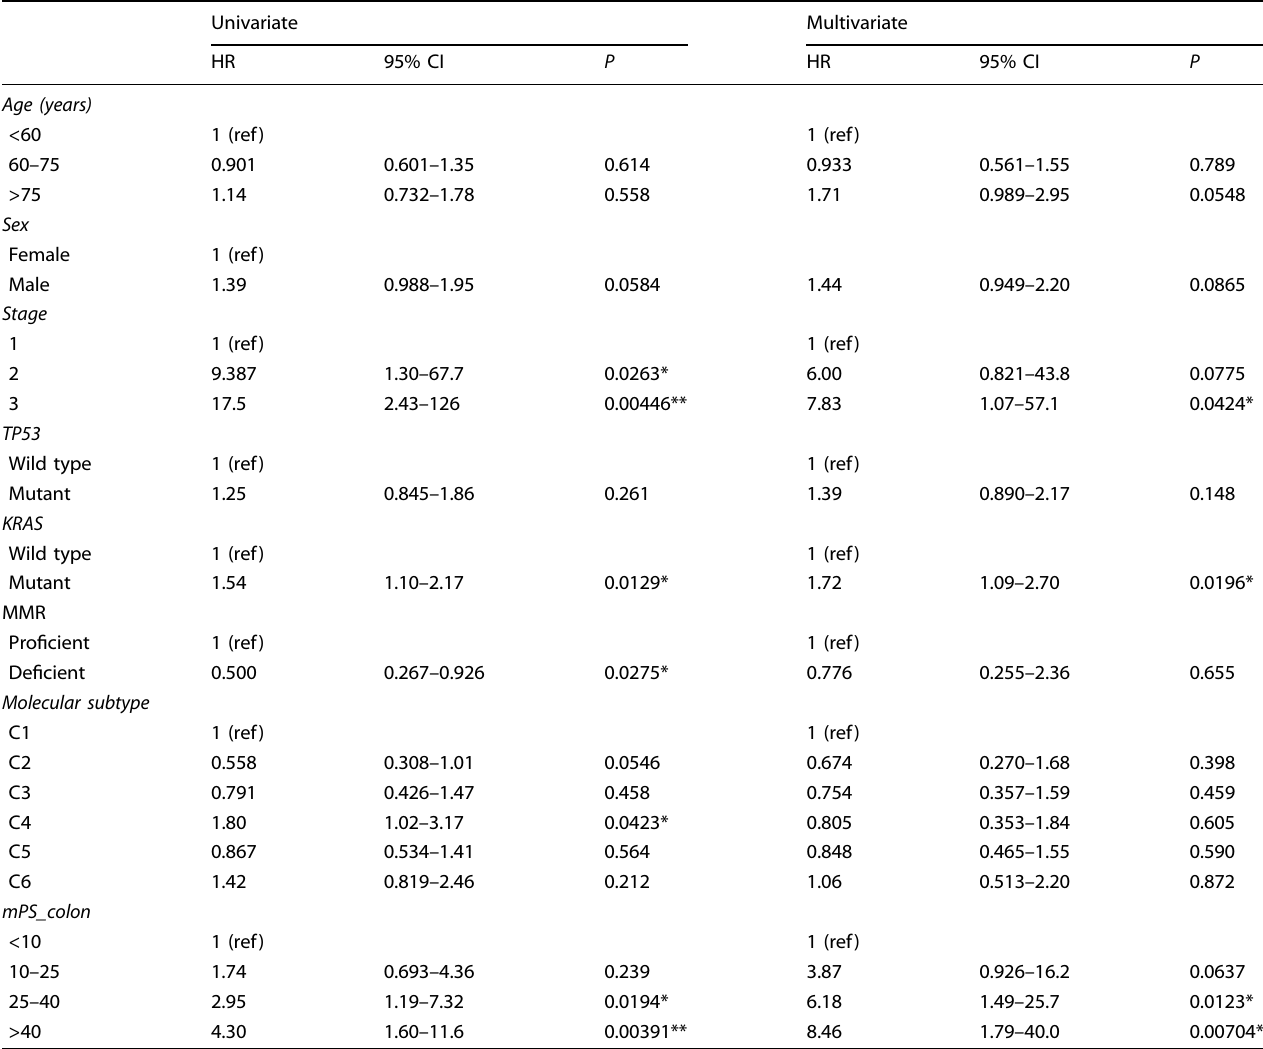
Table 2. Univariate and multivariate analyses for relapse-free survival of metastasis-free patients with colorectal cancer in the GSE39582 cohort. Univariate